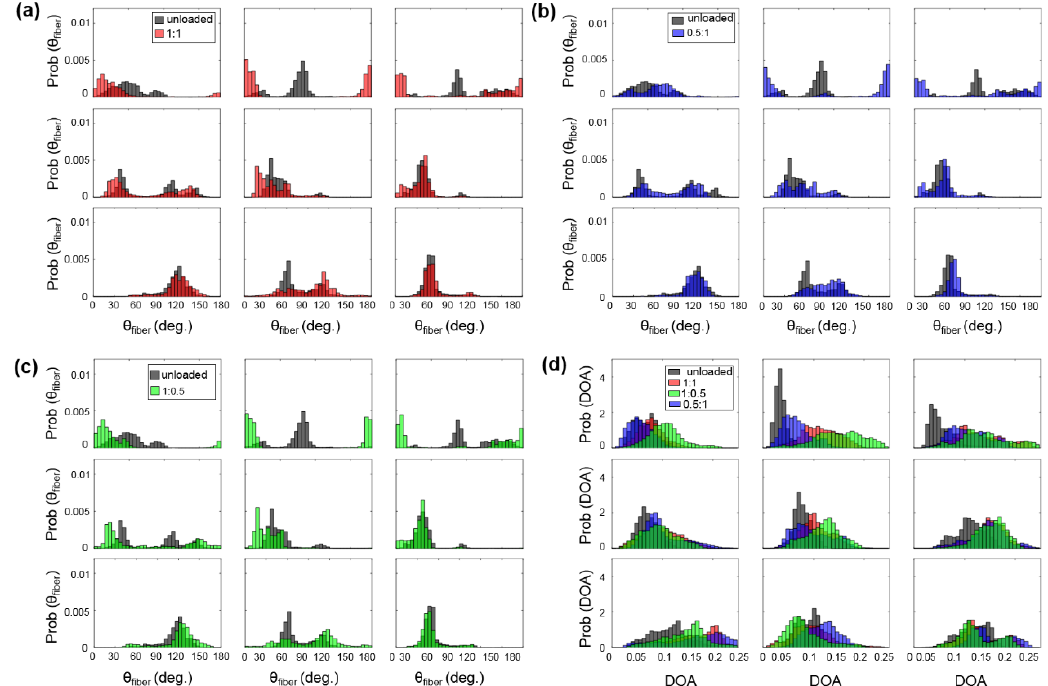
Figure A4. 3 × 3 grid comparisons of the predicted θ fiber : ( a ) between unloaded and equibiaxial loading, ( b ) between unloaded and radially-dominate loading, and ( c ) between unloaded and circumferentially-dominated loading. ( d ) Comparison of the predicted DOA among all the states for the TVSL specimen of heart #1.